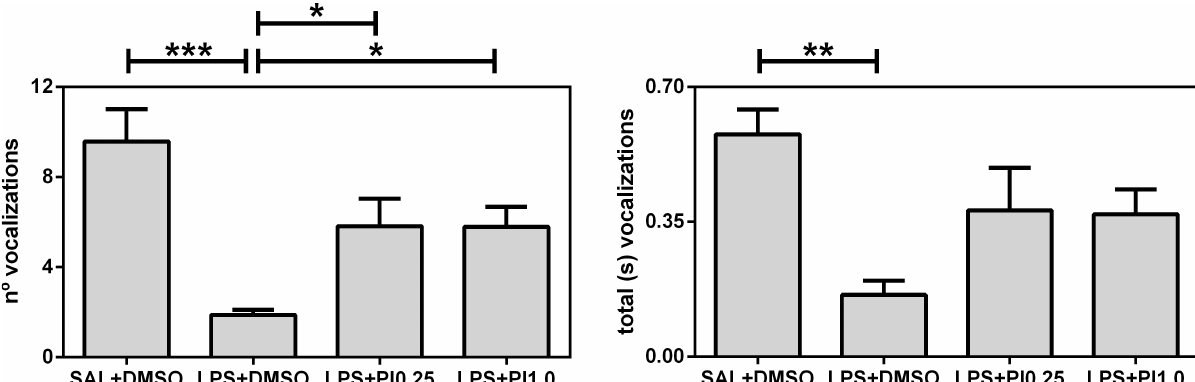
Fig 2. Ultrasonic vocalizations. The effects of prenatal LPS (100 μg/kg at gestational day 9.5) and postnatal pioglitazone (0.25 and 1.0 mg/kg/day between postnatal days 21 and 29) exposures on 50-kHz ultrasonic vocalizations in juvenile male rat offspring. SAL+DMSO, prenatal saline injection and postnatal daily DMSO injection; LPS+DMSO, prenatal LPS injection and postnatal daily DMSO injection; LPS+PI0.25, prenatal LPS injection and postnatal pioglitazone 0.25 mg/kg/day; LPS+PI1.0, prenatal LPS injection and postnatal pioglitazone 1.0 mg/kg/day ( n = 8 rats/group). (cid:3) p < 0.05, (cid:3)(cid:3) p < 0.01, and (cid:3)(cid:3)(cid:3) p < 0.0001 (one-way ANOVA followed by the Newman-Keuls test). The data are expressed as the mean ± the SEM.